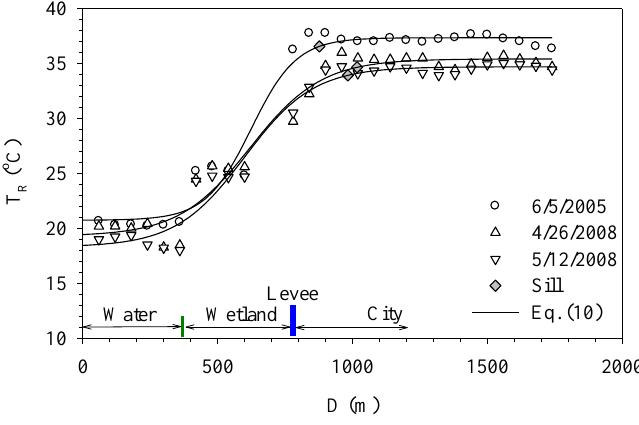
Figure 6. Temperature variation profiles at Hua-Jiang Bridge.